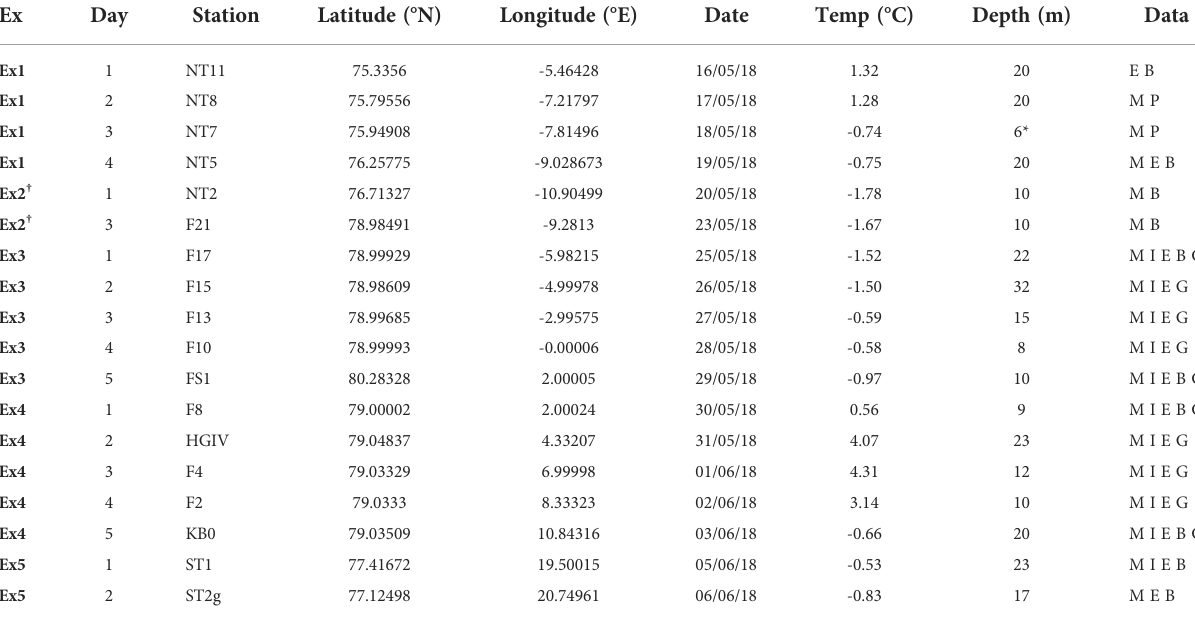
TABLE 1 Locations of the stations sampled on research cruise JR17005 in May and June